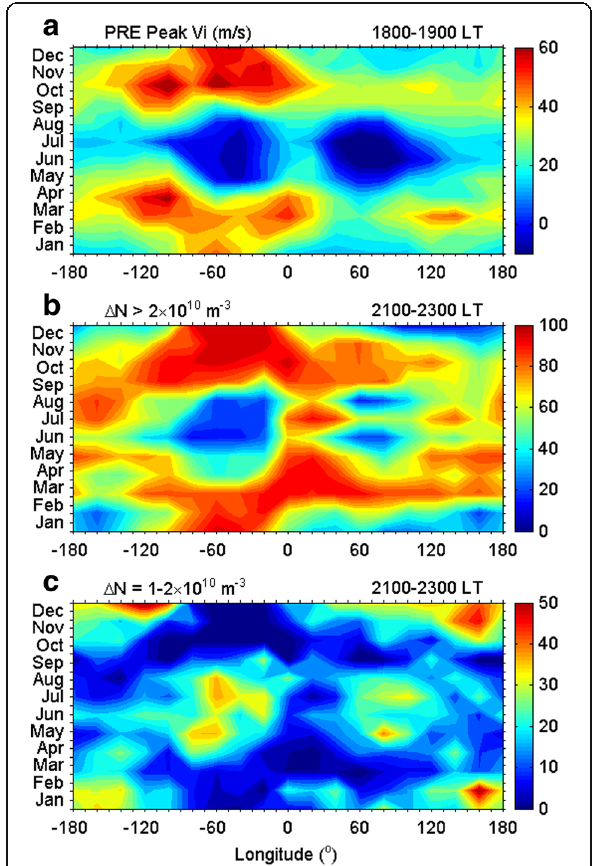
Fig. 9 The longitude-month distributions of a the vertical ion drift at the PRE peak, b the occurrence probability of large amplitude ESF irregularities with Δ N >2×10 10 m − 3 , and c the occurrence probability of small-amplitude ESF irregularities with Δ N =1 – 2×10 10 m − 3 measured by C/NOFS during moderate solar activity in 2011 – 2014,